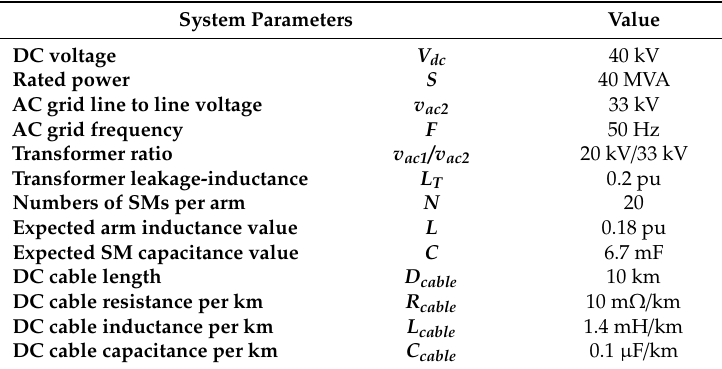
Table 1. Simulation Parameters.